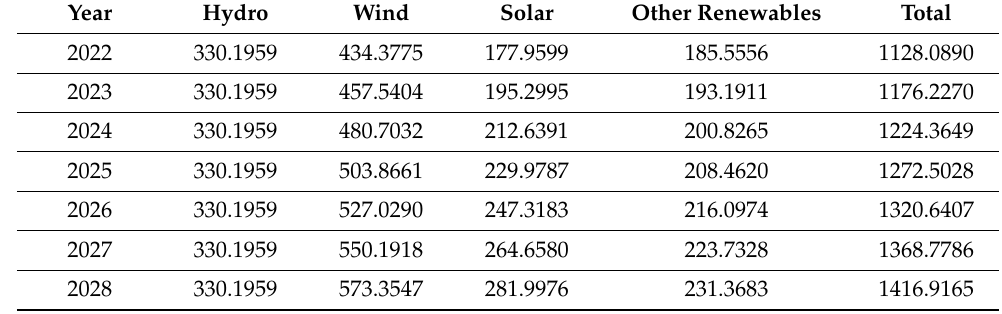
Table 3. Forecast-renewable electricity produced in EU27 in TWh. Source: own elaborations.